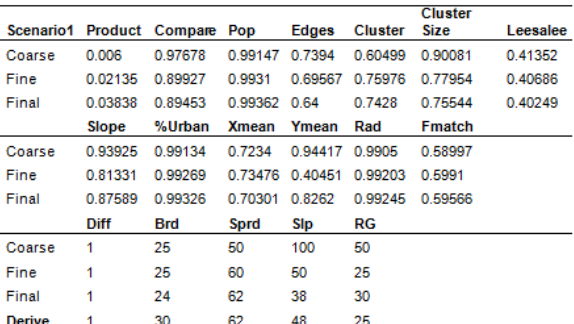
Table 2. Calibration results for